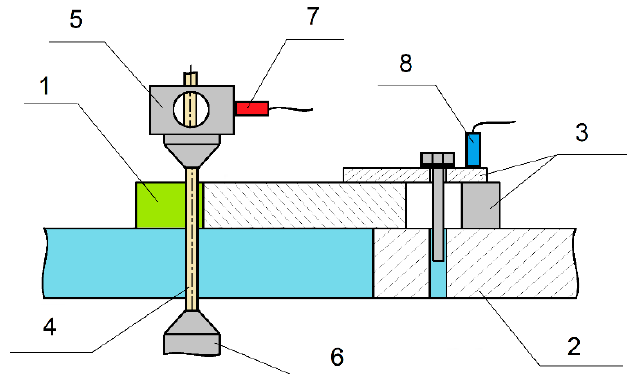
Figure 1. The positions of accelerometers in the working area of EDM machine, where (1) is a workpiece, (2) is a worktable, (3) is a fastening system, (4) is a wire electrode, (5) is an upper guide, (6) is a lower guide, (7) is an upper accelerometer, (8) is a lower accelerometer.